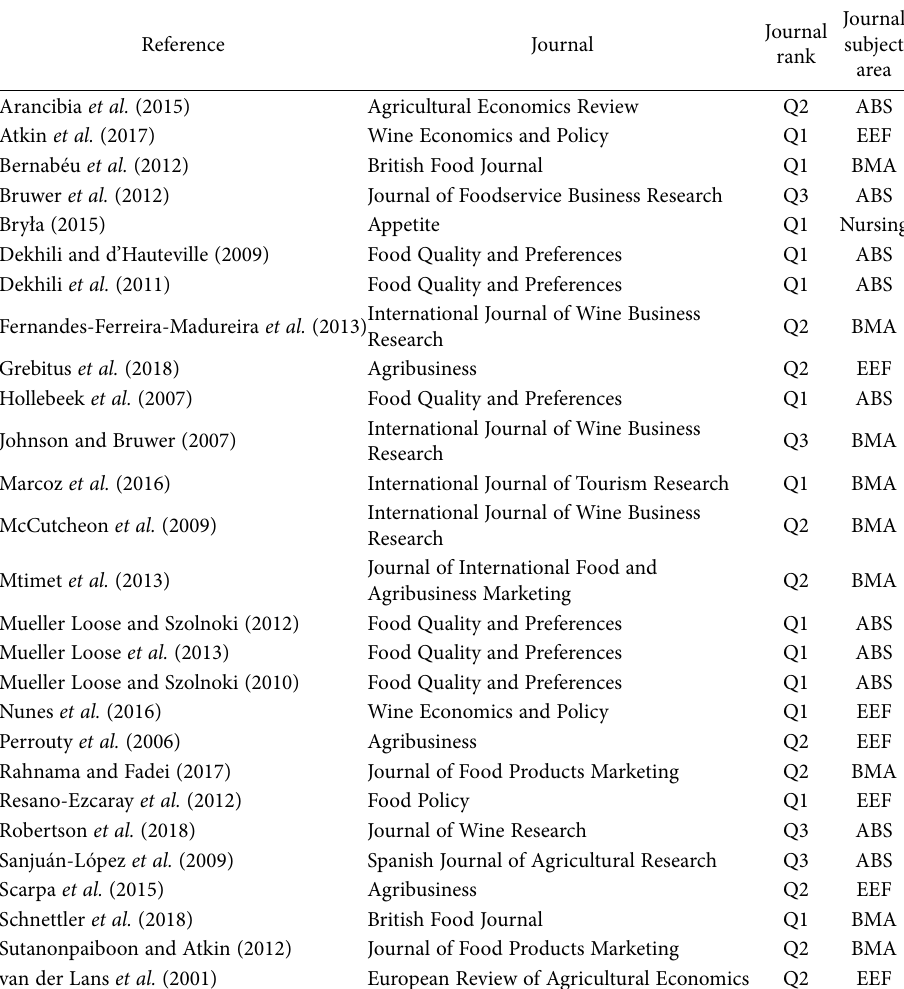
Table 1. List of articles included in the